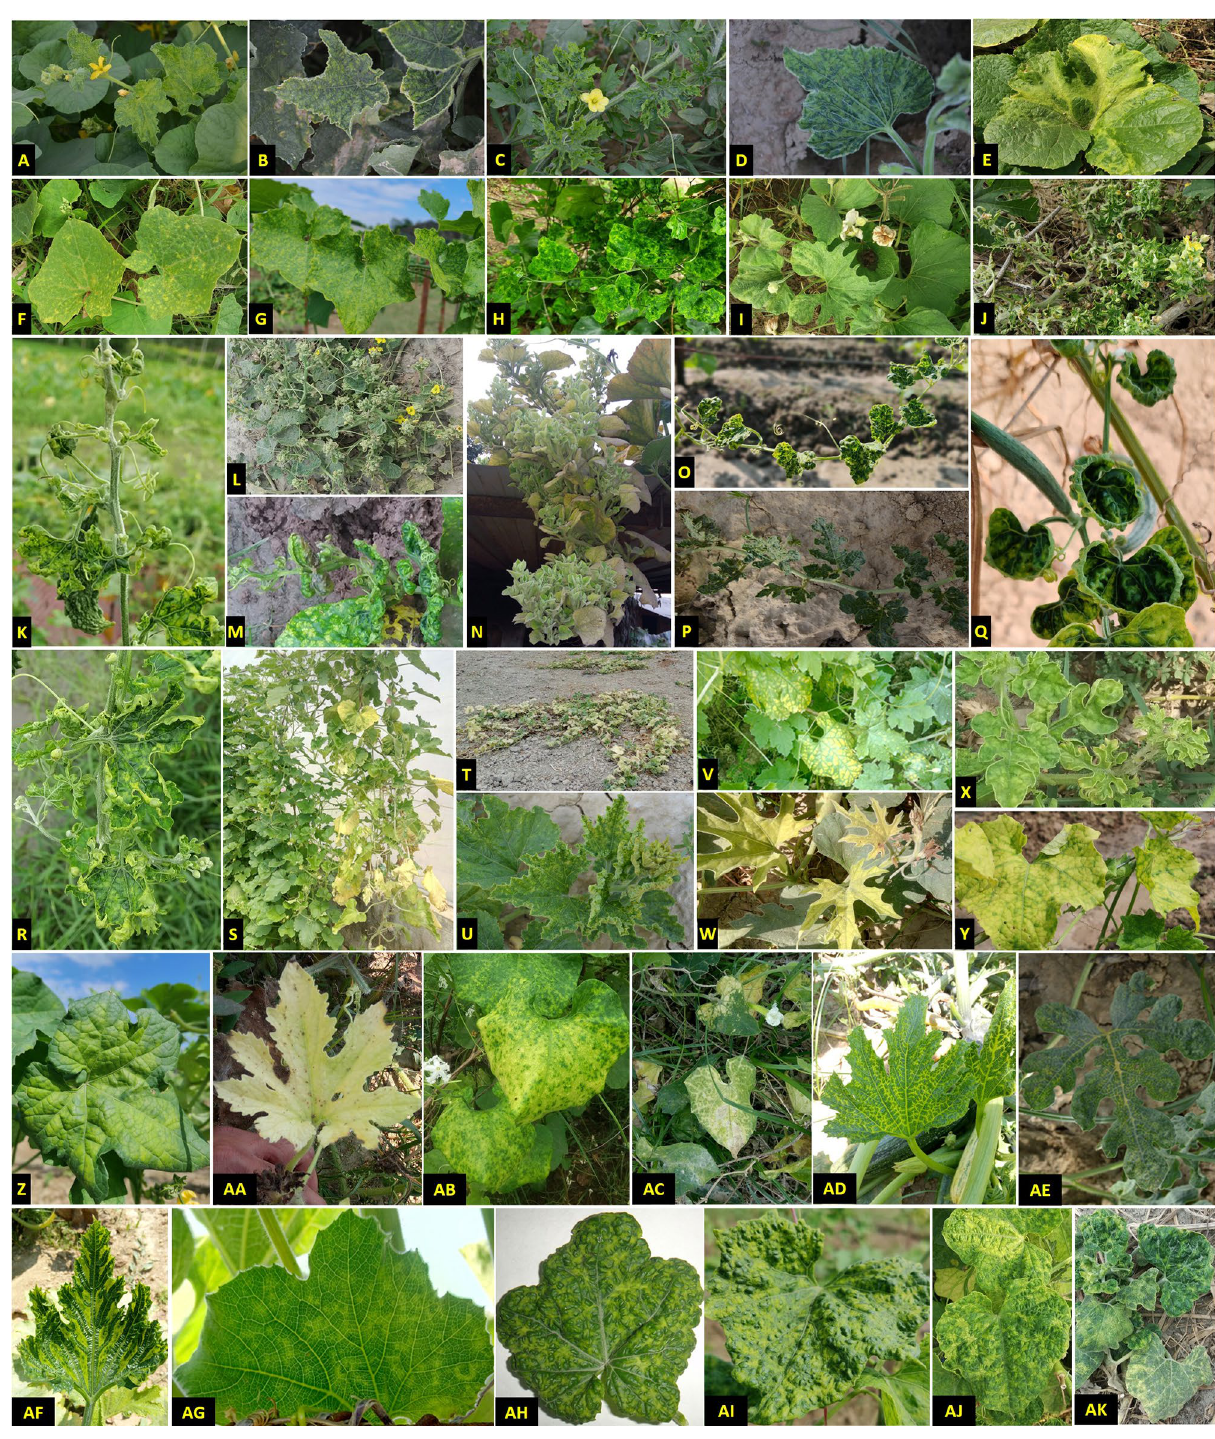
Figure 1. Symptoms of mosaic on Long melon ( A ), Cucumber ( B ), Bitter gourd ( C ), Bottle gourd ( D ), Pumpkin ( E ), Pointed gourd ( F ), Satputia ( G ), and Ivy gourd ( H ); leaf malformations on Bottle gourd ( I ), Bitter gourd ( J , K ), Cucumber ( L ), Sponge gourd ( M ), Bottle gourd ( N ), Satputia ( O ); leaf curl on Watermelon ( P ), Sponge gourd ( Q ), and Bitter gourd ( R ); chlorosis and yellowing on Musk melon ( S ), Pumpkin ( T , U ), Bitter gourd ( V ), Bottle gourd ( W ), Watermelon ( X ), Satputia ( Y , Z ), Ash gourd ( AA ), and Snake gourd ( AB ); clearing of veins in Ponited gourd ( AC ), Squash ( AD ) and Watermelon ( AE ); vein banding in Squash ( AF ); ring spots on Bottle gourd leaves ( AG ); and puckering and blistering of leaves on sponge gourd ( AH ), Satputia ( AI ), Ridge gourd ( AJ ) and Pumpkin ( AK